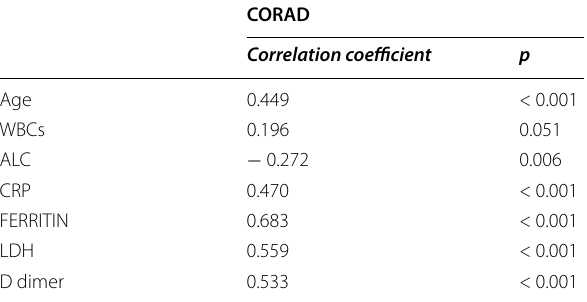
Table 8 Correlation of CORAD with other studied parameters